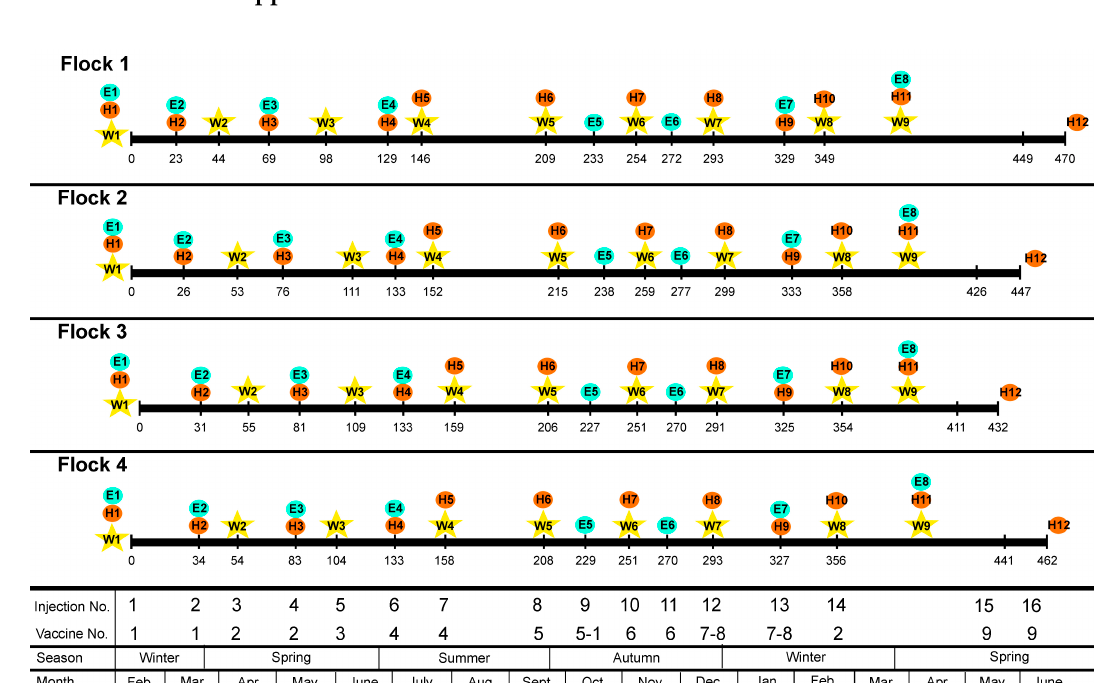
Figure A1. Inoculation schedule for each flock individually. All flocks were subjected to the same inoculation schedule and experimental procedures. Differences in the number of days between inoculations in the different flocks and other experimental procedures are shown. Each injection date is indicated by a vertical line and a number. W: Weight measurement. E: Clinical examination. H: Hematological analysis. Information on the injection and vaccines number, season, and month is also provided. Information about the vaccines used is presented in Table A2 (Appendix C).